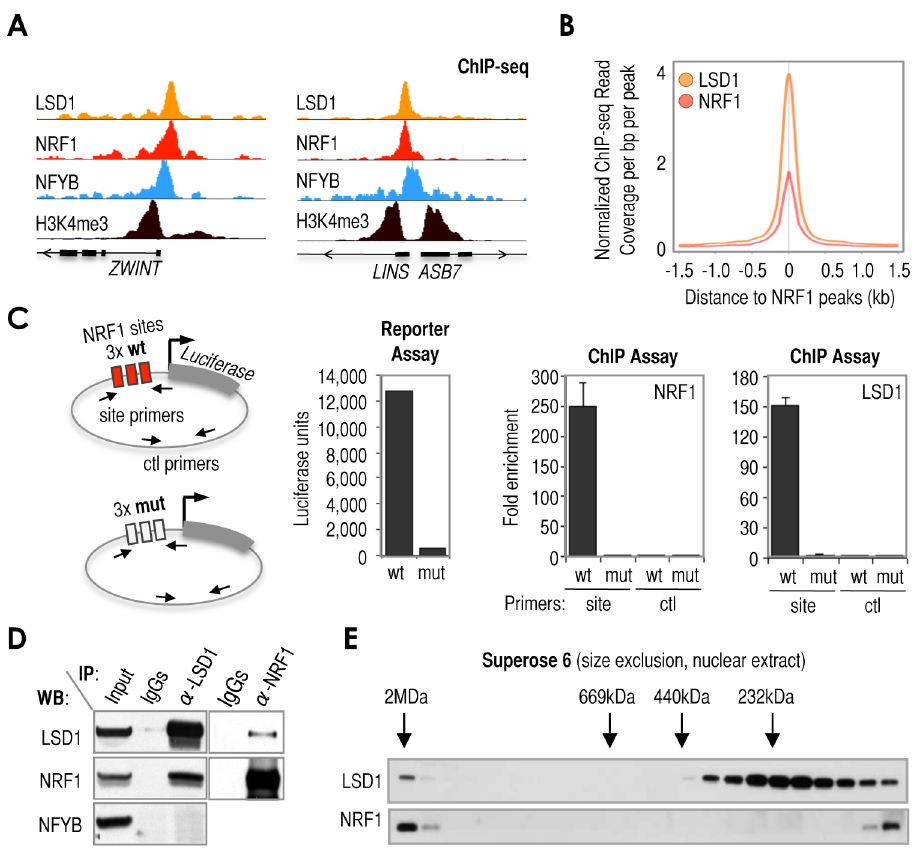
Figure 3. Cardinal motif NRF1 dictates the recruitment of KDM LSD1 via TF NRF1. ( A ) Representative examples of ChIP-seq tracks showing precise co-alignment of NRF1 and LSD1. These particular loci ( ZWINT and LINS-ASB7 ) were selected as representative despite being rare examples in which NRF1 binds nearby NFYB, but they should help to emphasize the good co-alignment between LSD1 and NRF1 using NFYB as reference. The track of ChIP-seq data for H3K4me3 was also included as reference. Annotation of Ref-seq genes is included. ( B ) Meta-analysis of sequencing read density of LSD1 ChIP-seq (orange) and NRF1 ChIP-seq (red) signals around NRF1 peaks (center of the panel). ( C ) Left: Scheme of two constructs engineered to contain 3 6 wild-type NRF1 sequences (3xwtNRF1, as in Figure 2A ) or 3 6 mutated NRF1 sequences (3xmutNRF1) upstream the luciferase reporter gene. Panels: Luciferase assay with 3xwtNRF1- or 3xmutNRF1-transected U2OS cells (left panel) and ChIP analyses of NRF1 and LSD1 at 3xwtNRF1 and 3xmutNRF1 sites (middle and right panels, respectively). For ChIP analyses, two regions were amplified (labeled in the scheme, left): one region covering 3xwtNRF1 or 3xmutNRF1 sites (depending on the construct), amplified with primers named as ‘site’; and the other region covering a distal, control area (the same in both constructs), amplified with primers named as ‘ctl’. ( D ) Co-immunoprecipitation (IP) assay with the set of antibodies indicated on top of the panel, and detection with the set of antibodies indicated in the left of the panel. ( E ) Size exclusion chromatography (Superose 6) of nuclear extracts obtained from MCF7 cells. Analysis of elution fractions by Western blot using anti-LSD1 (top) and anti-NRF1 (bottom) antibodies. On top of the Western blot, elution of known molecular size markers is indicated (arrows). Voided volume was determined with Blue Dextran 2000 ( .